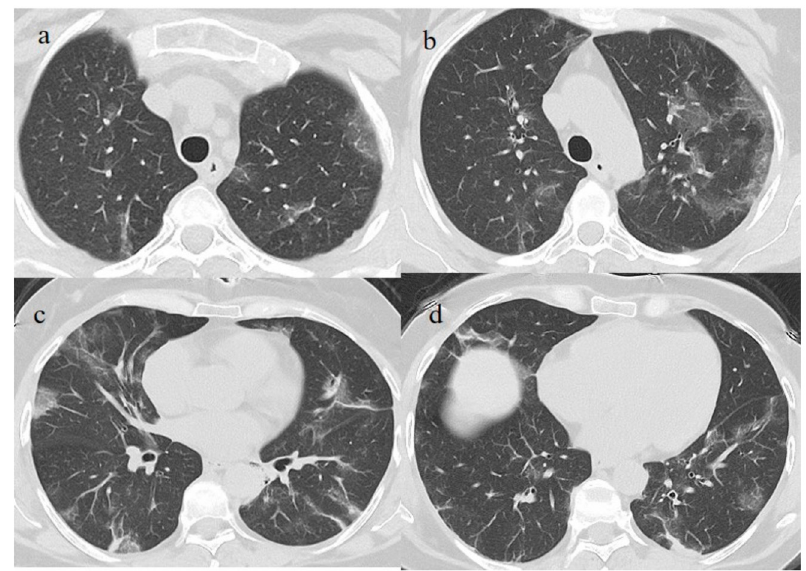
Figure 3. Chest CT performed on 17 June. ( a , b ) Some new GGO areas in the left superior lobe with the disappearance of the GGO areas in the superior lobe. ( c , d ) An evolution in crazy paving and the consolidation of some previous GGO in the middle and inferior